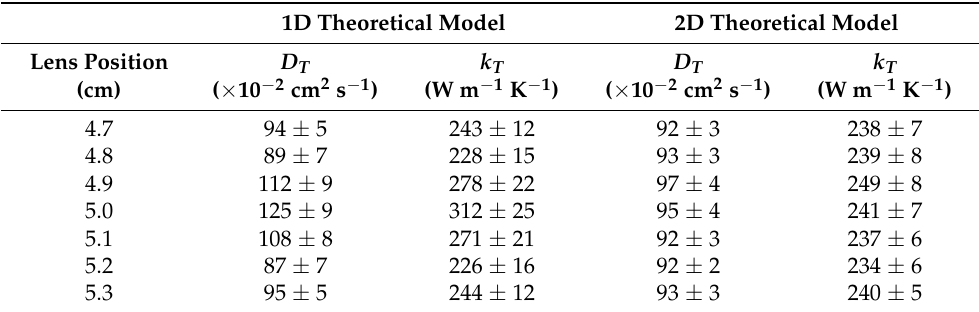
Table 2. Values of determined thermal diffusivity D T and conductivity k T of the Al sample for different positions of PuB forming lens and application of 1D and 2D theoretical model.